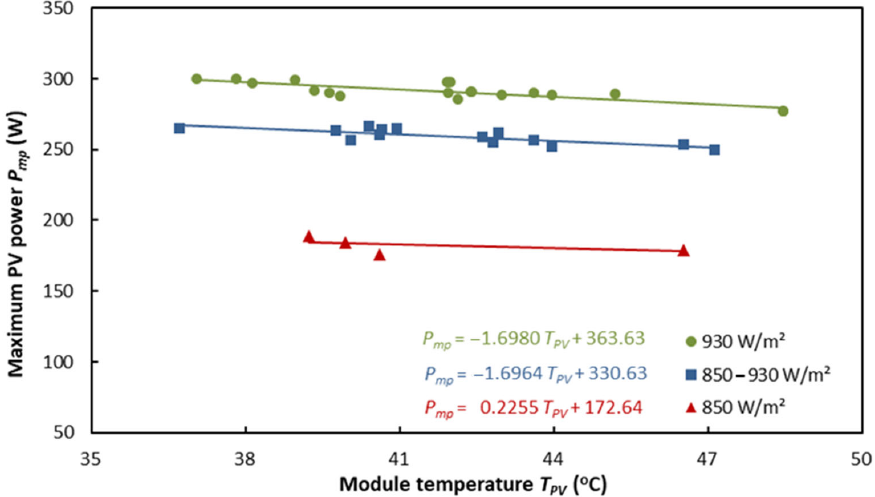
Figure 15. Outdoor maximum power as a function of module temperature under various irradiance levels.